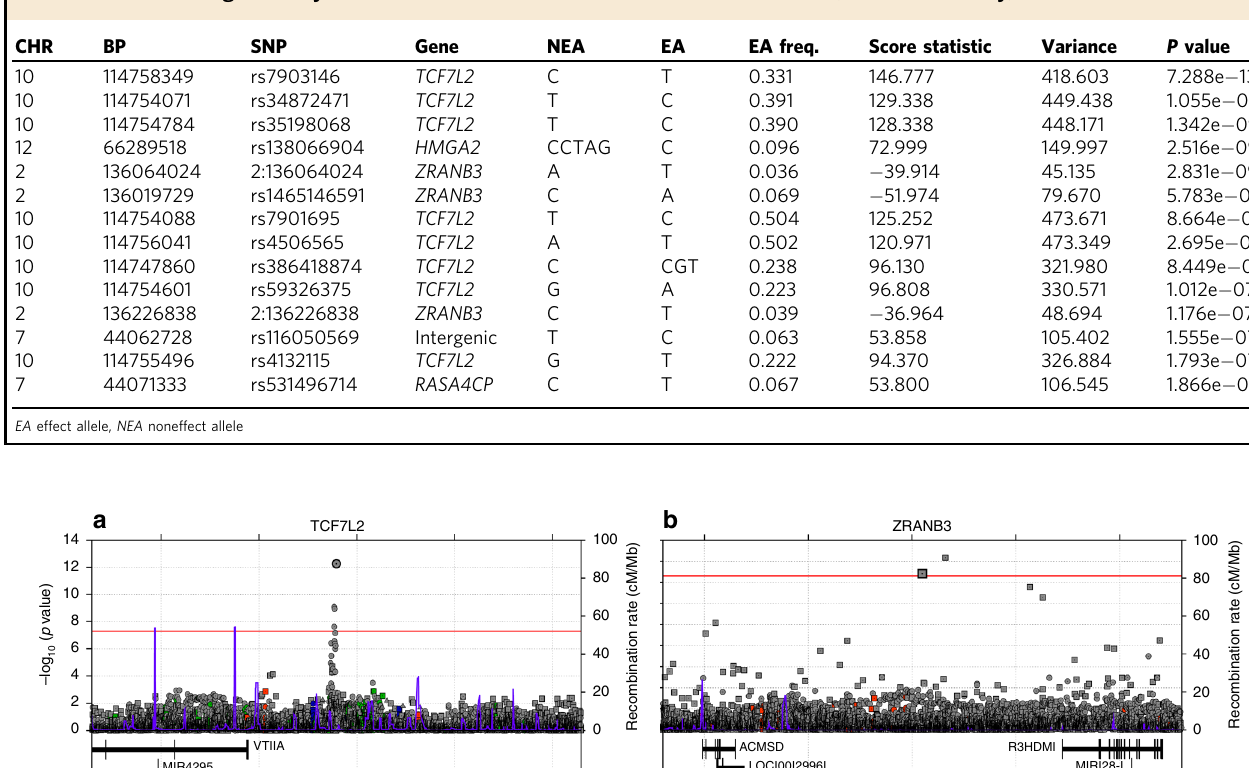
Fig. 1 Manhattan plot of discovery GWAS: the AADM study Table 1 SNPs most signi fi cantly associated with T2D in 5231 sub-Saharan Africans (the AADM study)